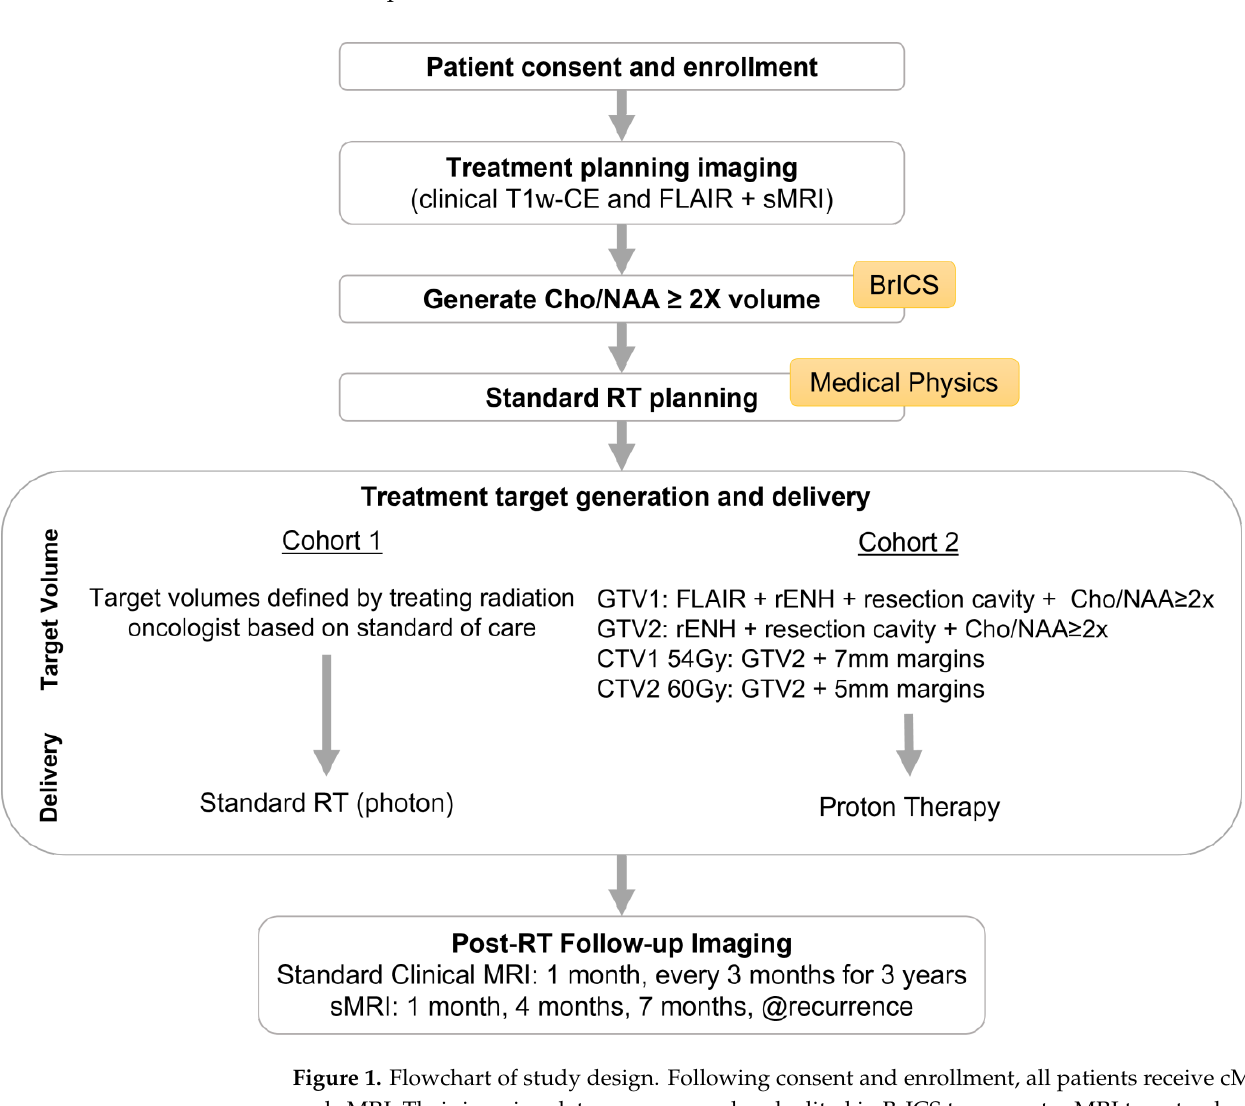
Figure 1. Flowchart of study design. Following consent and enrollment, all patients receive cMRI and sMRI. Their imaging data are processed and edited in BrICS to generate sMRI target volumes before exporting to the RT planning system for execution. The target volumes for c1 are based solely on cMRI, and they receive photon RT based on standard of care. The target volumes for c2 are based on cMRI + sMRI, and they receive proton therapy. Both cohorts receive the same post-RT follow-up imaging protocol of cMRI beginning at 1 month post-RT and continuing in 3-month intervals up to 3 years with concurrent sMRI for the first three timepoints and then followed as needed or at the time of tumor recurrence.